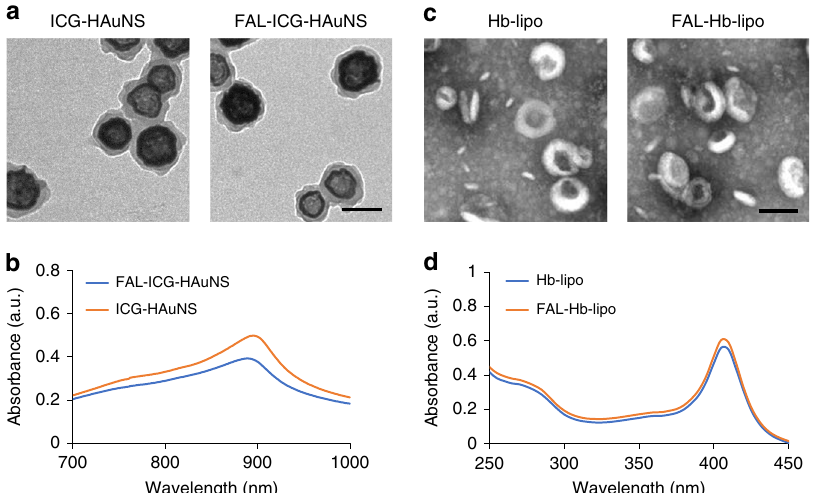
Fig. 1 Characterization. a Representative transmission electron microscopic (TEM) images of ICG-HAuNS and FAL-ICG-HAuNS. Scale bars, 100 nm. b Ultraviolet – visible (UV-vis) absorption spectra of ICG-HAuNS and FAL-ICG-HAuNS (indocyanine green (ICG): 10 μ g/mL; hollow gold nanospheres (HAuNS): 20 μ g/mL). c Representative TEM images of Hb-lipo and FAL-Hb-lipo. Scale bars, 100 nm. d UV-vis absorption spectra of Hb-lipo and FAL-Hb- lipo (hemoglobin (Hb): 80 μ